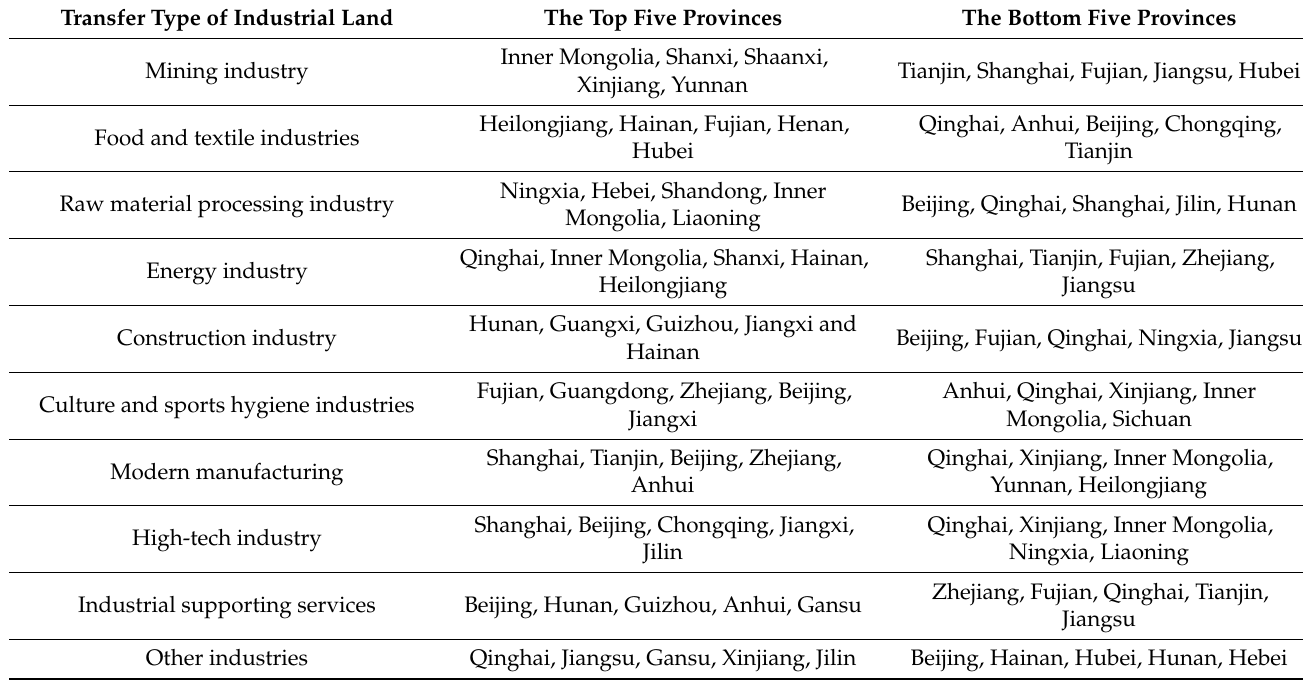
Table 3. Regional distribution of advantage index of industrial land transfer scale in China. Transfer Type of Industrial Land The Top Five Provinces The Bottom Five